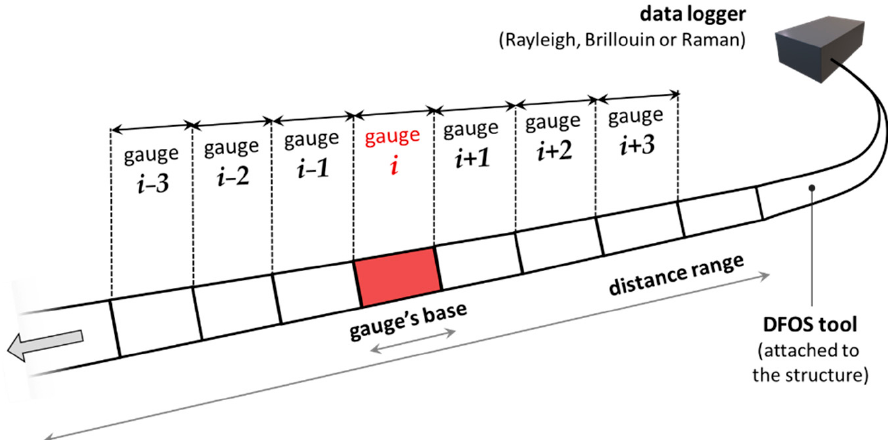
Figure 2. A simplified interpretation of spatial resolution in distributed measurements.